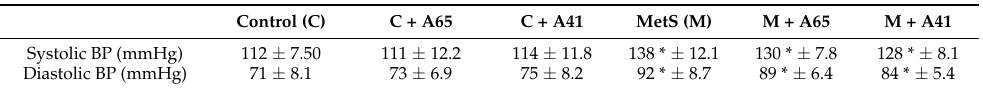
Table 2. Effect of AM6545 and AM4113 on systolic and diastolic blood pressure (BP) of metabolic syndrome (MetS)-induced